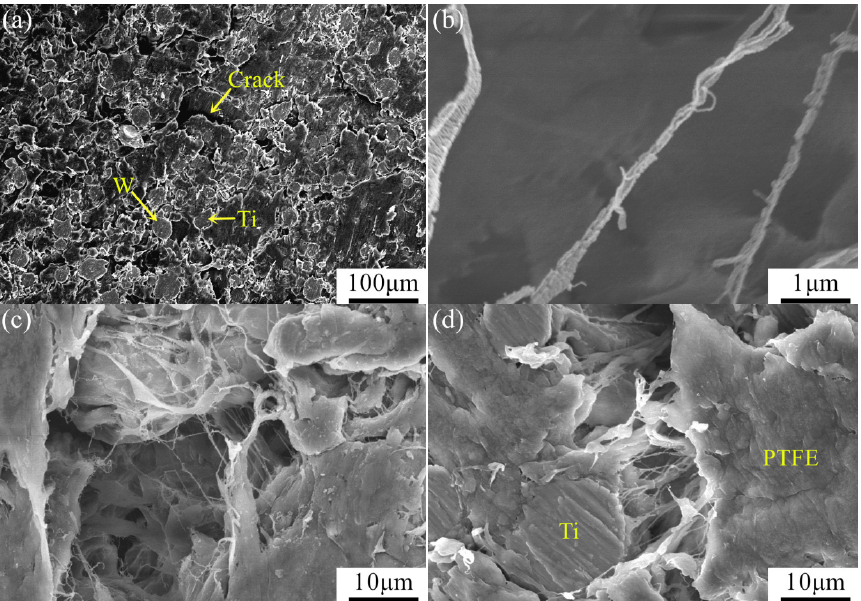
Figure 9. SEM micrographs of the sample residues: ( a ) overall view of sample surface; ( b ) enlarged view of PTFE nano-fibers; ( c ) network of PTFE nano-fibers; ( d ) crack in the metal/matrix interface and PTFE fibers connecting to metal particle.